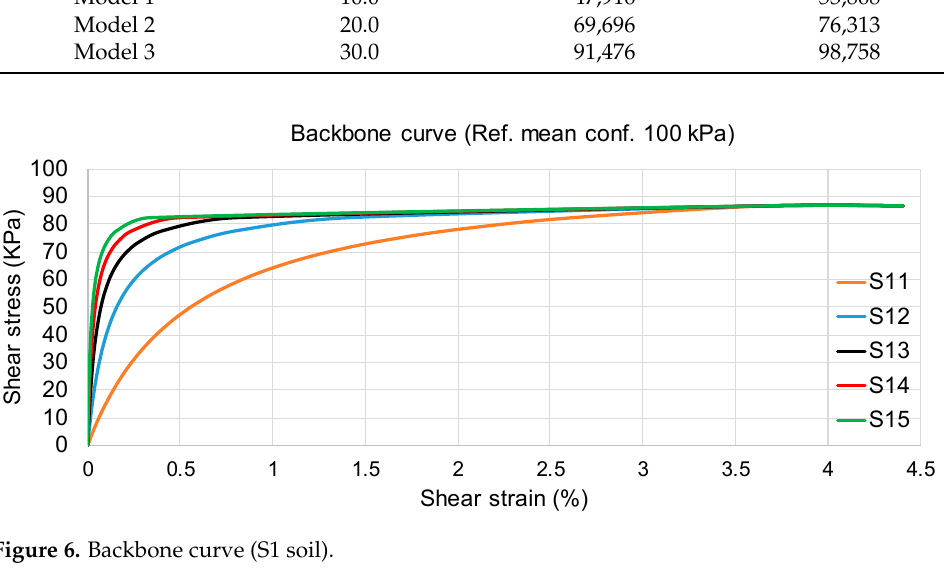
Figure 6. Backbone curve (S1 soil).